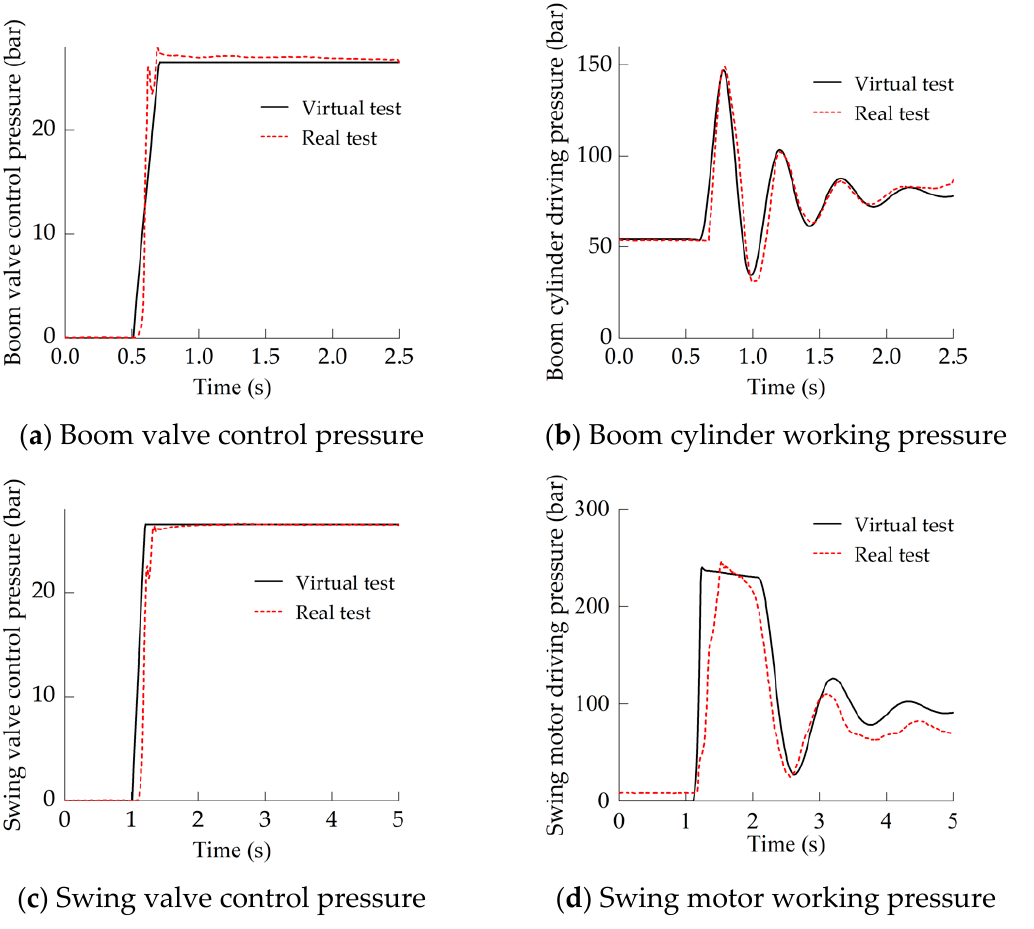
Figure 10. Comparison between virtual test and real test.